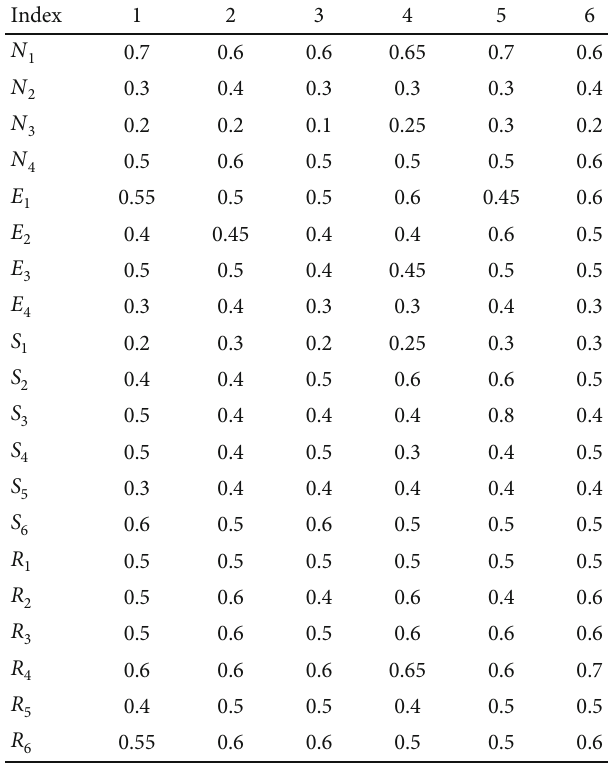
Table 3: Gas explosion vulnerability index score results obtained from experts.